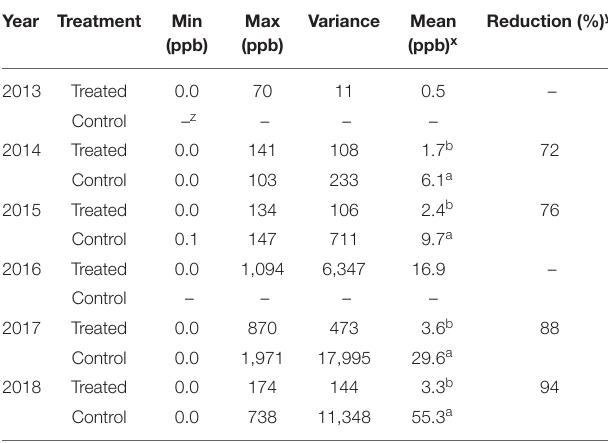
TABLE 7 | Aflatoxin concentration in samples from commercial maize grain aggregated from biocontrol-treated and control fields by commercial enterprises in Nigeria during